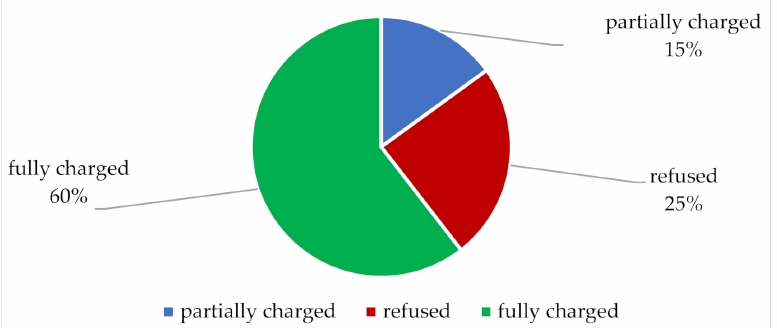
Figure 11. The success of recharging nonresidents in case of using one